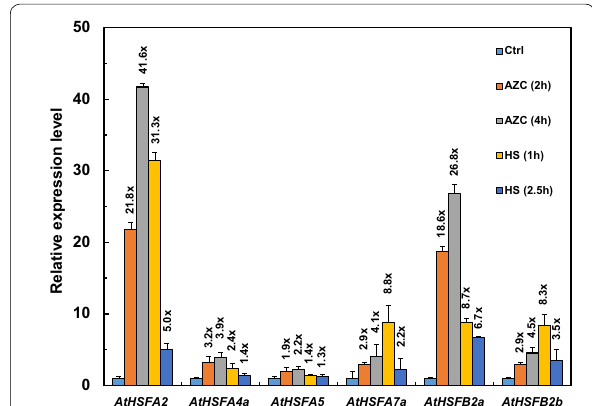
Fig. 1 Expression profiles of AtHSFs in Arabidopsis plants under AZC and HS treatment. RT‑PCR analysis of transcript levels in wild‑type (WT) seedlings treated with AZC and HS for the indicated times. Data are mean SE expression relative to that of non‑stressed control ± (Ctrl) from three independent experiments and the fold expression is